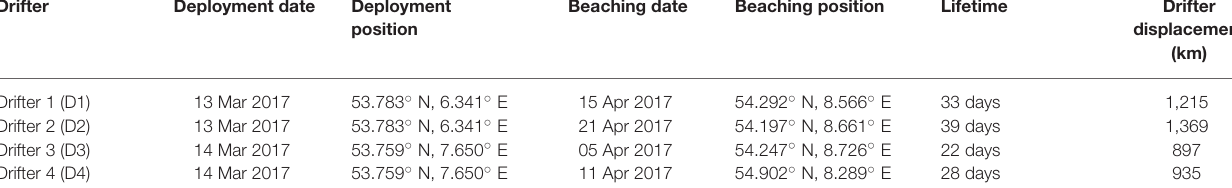
displacement (km)